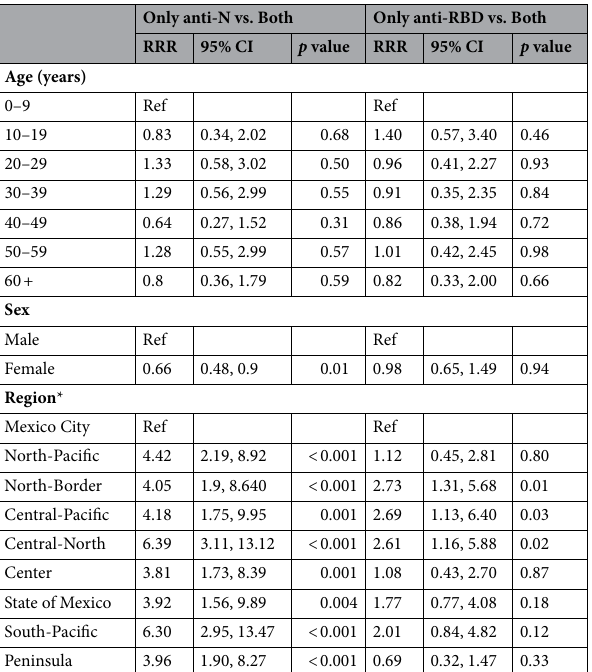
Table 4. Multinomial logistic model for only positive to anti-N and only positive to anti-S compared to double-positive (anti-N and anti-S). Ensanut-Covid19, 2020, Mexico. *North-Border: Chihuahua, Coahuila, Nuevo León, Tamaulipas; Central-Pacific: Colima, Jalisco, Michoacán; Central-North: Aguascalientes, Durango, Guanajuato, Querétaro, San Luis Potosí, Zacatecas; Center: Hidalgo, Tlaxcala, Veracruz; North- Pacific: Baja California, Baja California Sur, Nayarit, Sinaloa, Sonora; South-Pacific: Guerrero, Morelos, Oaxaca, Puebla; and Peninsula: Campeche, Chiapas, Quintana Roo, Tabasco,